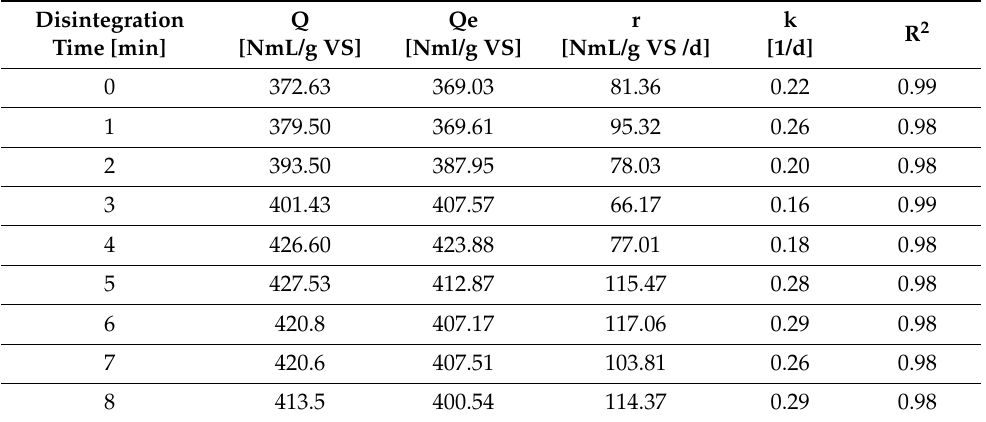
Table 2. Kinetic parameters of methane production from PEF-pre-treated substrate, as determined from the first-order